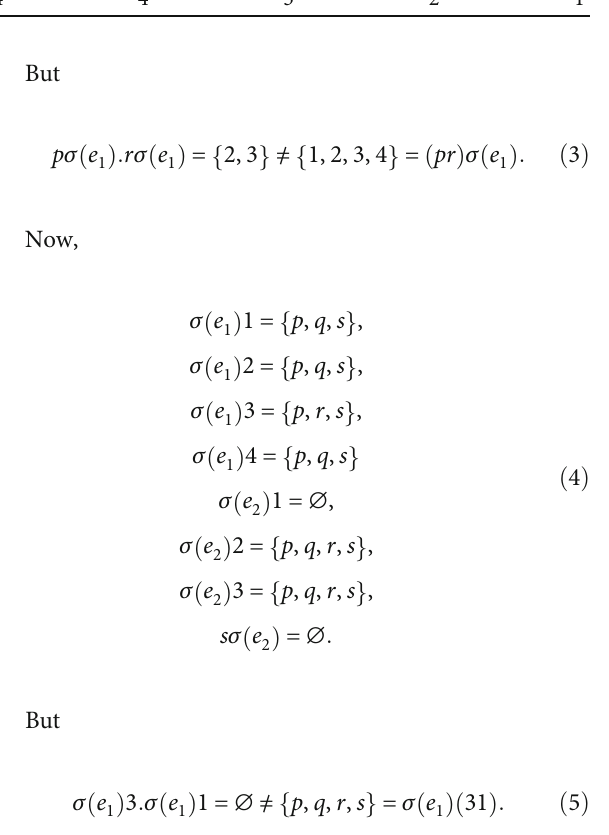
Table 2: Multiplication table for U